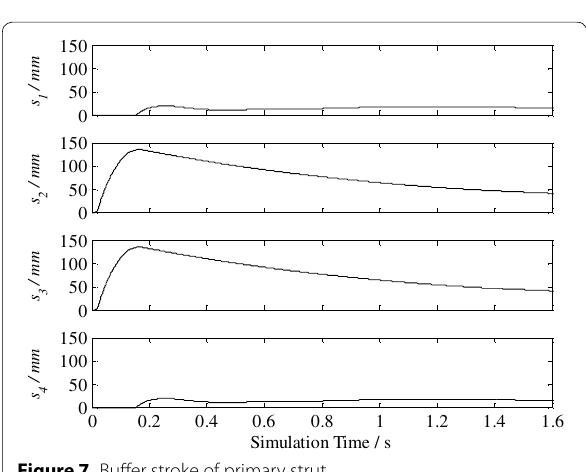
Figure 7 Buffer stroke of primary